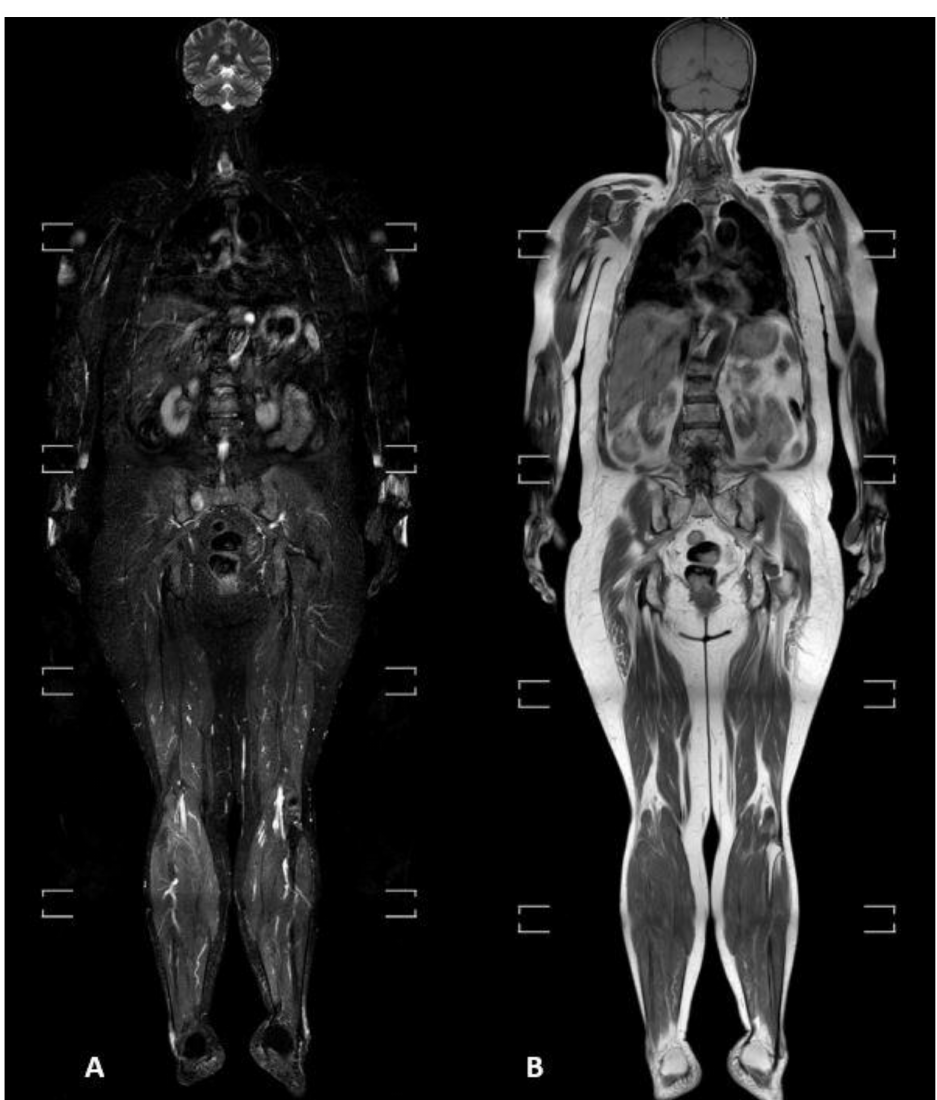
Figure 1. ( A ) T2-weighted short-tau inversion recovery (STIR) and ( B ) T1-weighted turbo spin-echo sequences acquired on the coronal plane from the skull vertex to